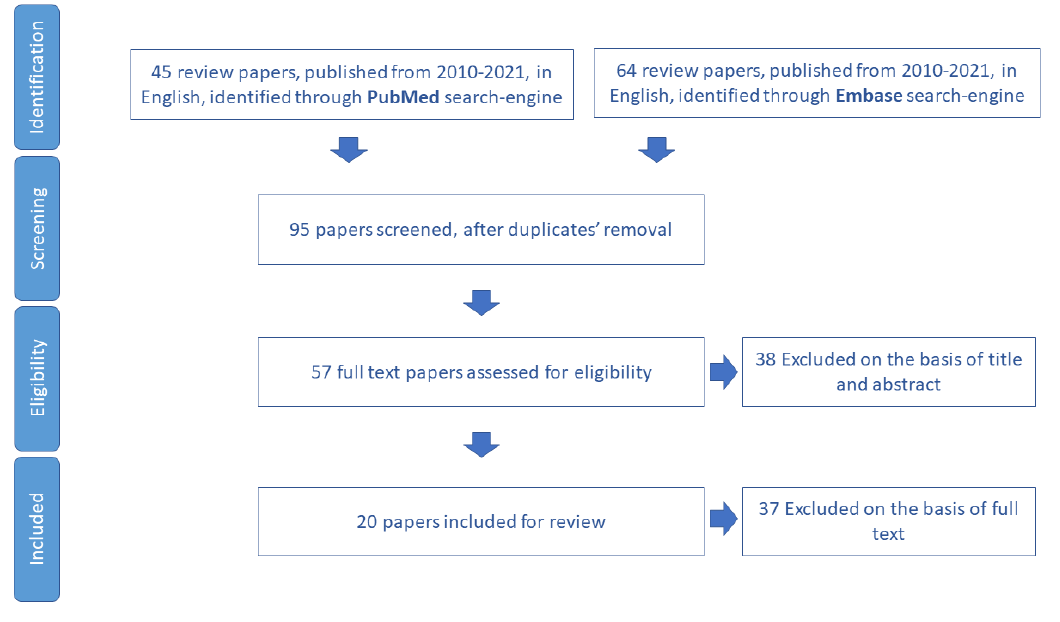
Figure 2. Process of study selection for polypharmacy domain. Table 2. Prescription appropriateness and adherence assessment tools scores.